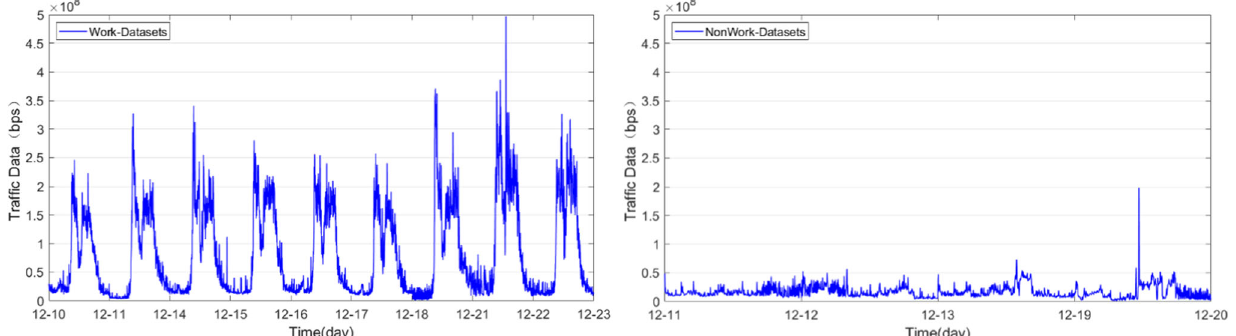
Fig. 4 The workdays and non-workdays data from Dec 11, 2021, to Dec 23, 2021